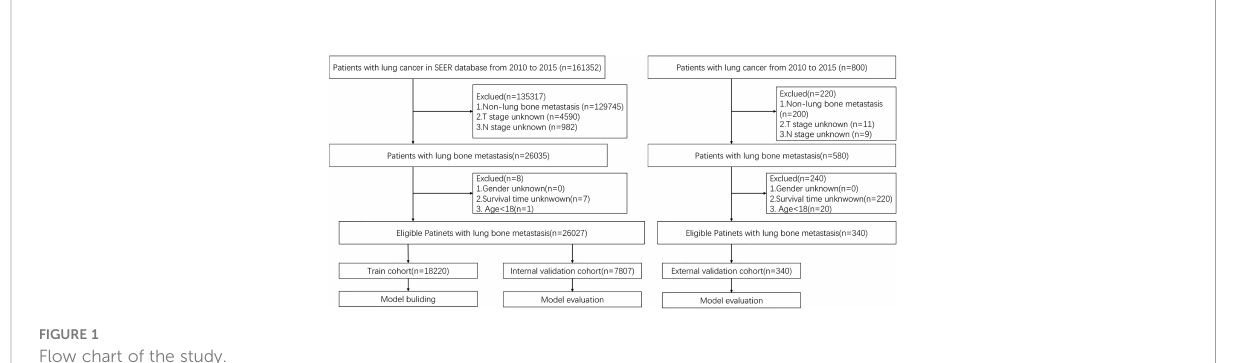
FIGURE 1 Flow chart of the